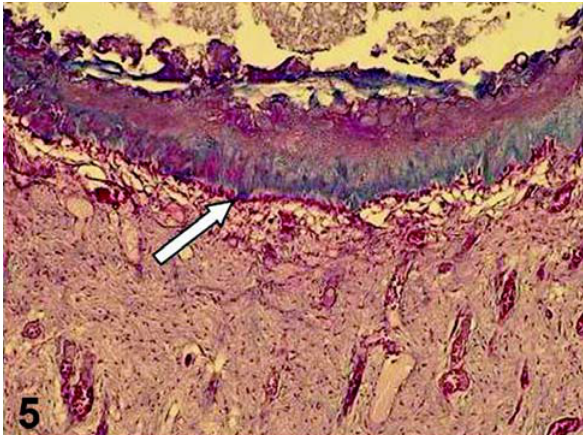
FIGURE 5- Pulp capped with a dental material that present high pH (MTA). Sixty days after the pulp therapy, a defined hard tissue barrier was formed, which was underlined by a new layer of odontoblast-like cells (arrow). Masson’s Trichrome, ×86